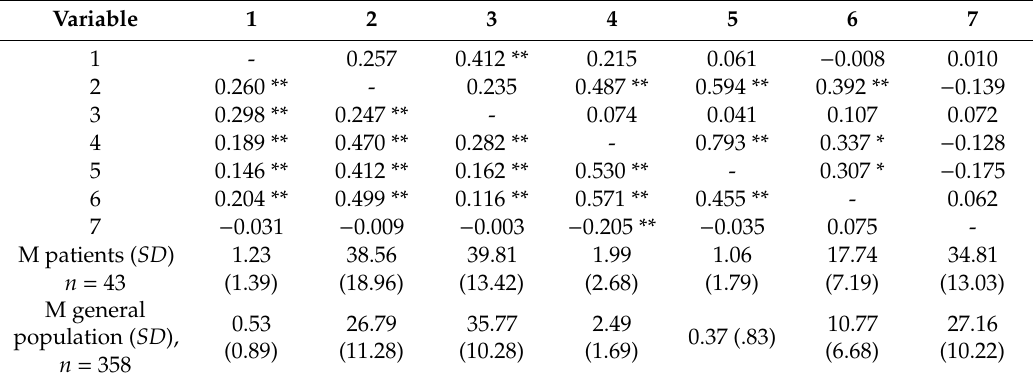
Table 1. Means, standard deviations, and correlation for all variables included in the model.